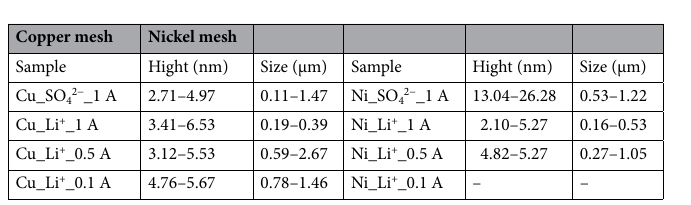
Table 1. Summary of height and size ranges after each